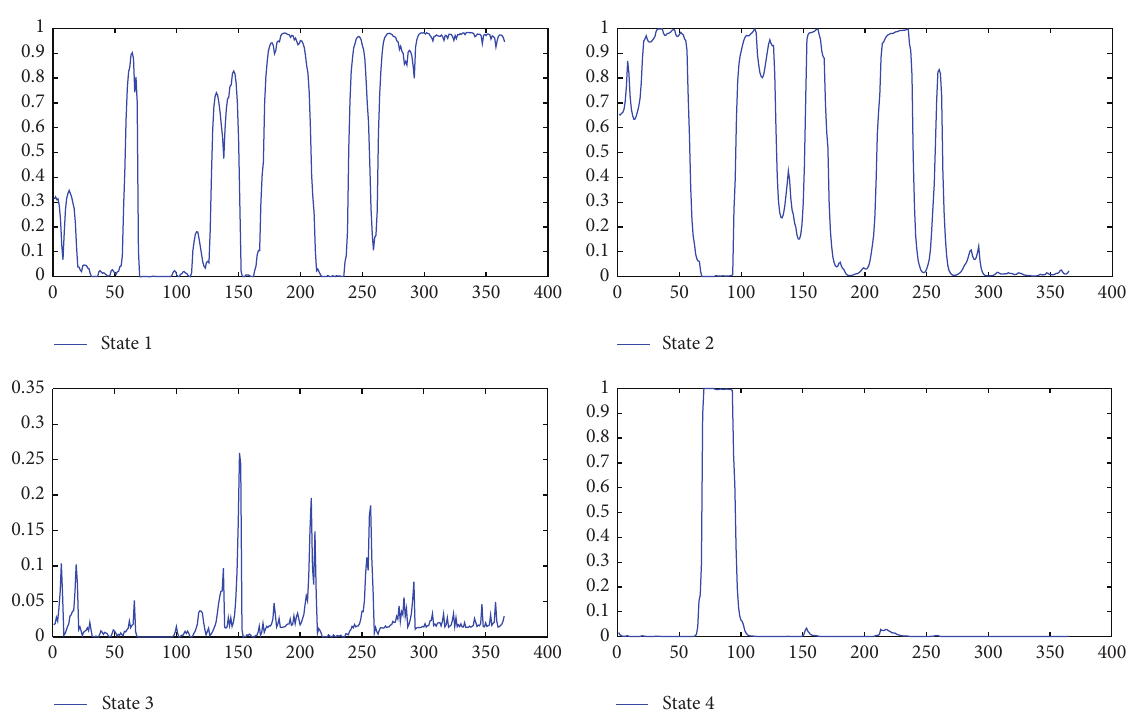
Figure 4: Smoothed probabilities P (𝑆 𝑡 = 𝑘 | 𝜓 𝑇 ) for 𝑡 ∈ Λ , 𝑘 ∈ {1,2,3,4}